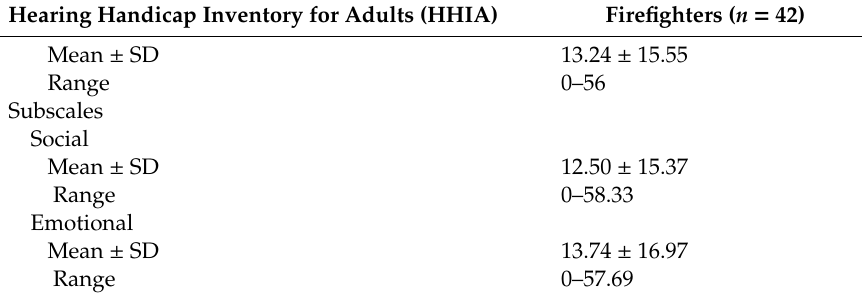
Table 2. Self-perceived hearing handicap scores.